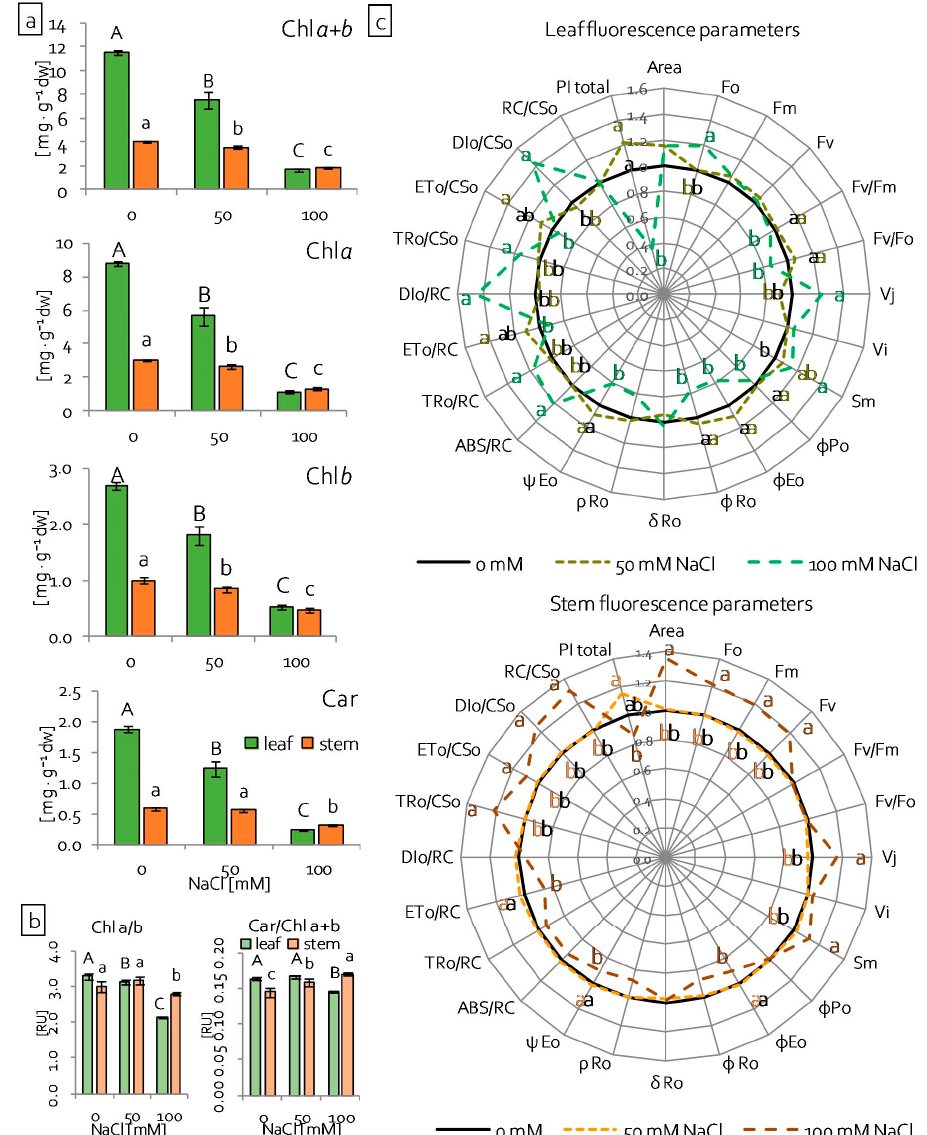
Figure 4. Reaction of the grass pea leaf and stem photosynthetic apparatus to salinity: ( a ) photosynthetic pigment content ( n = 5); ( b ) pigment ratios ( n = 5); ( c ) structural and functional parameters of PSII ( n = 10); Chl a+b —total chlorophylls, Chl a —chlorophyll a , Chl b —chlorophyll b , Car—carotenoids; all of the values in c were expressed relative to the control (set as 1); abbreviations—see chapter 4.3.2.; RU—relative units; different letters—statistically significant differences within each organ (leaf-uppercase, stem-lowercase) at p ≤ 0.05.